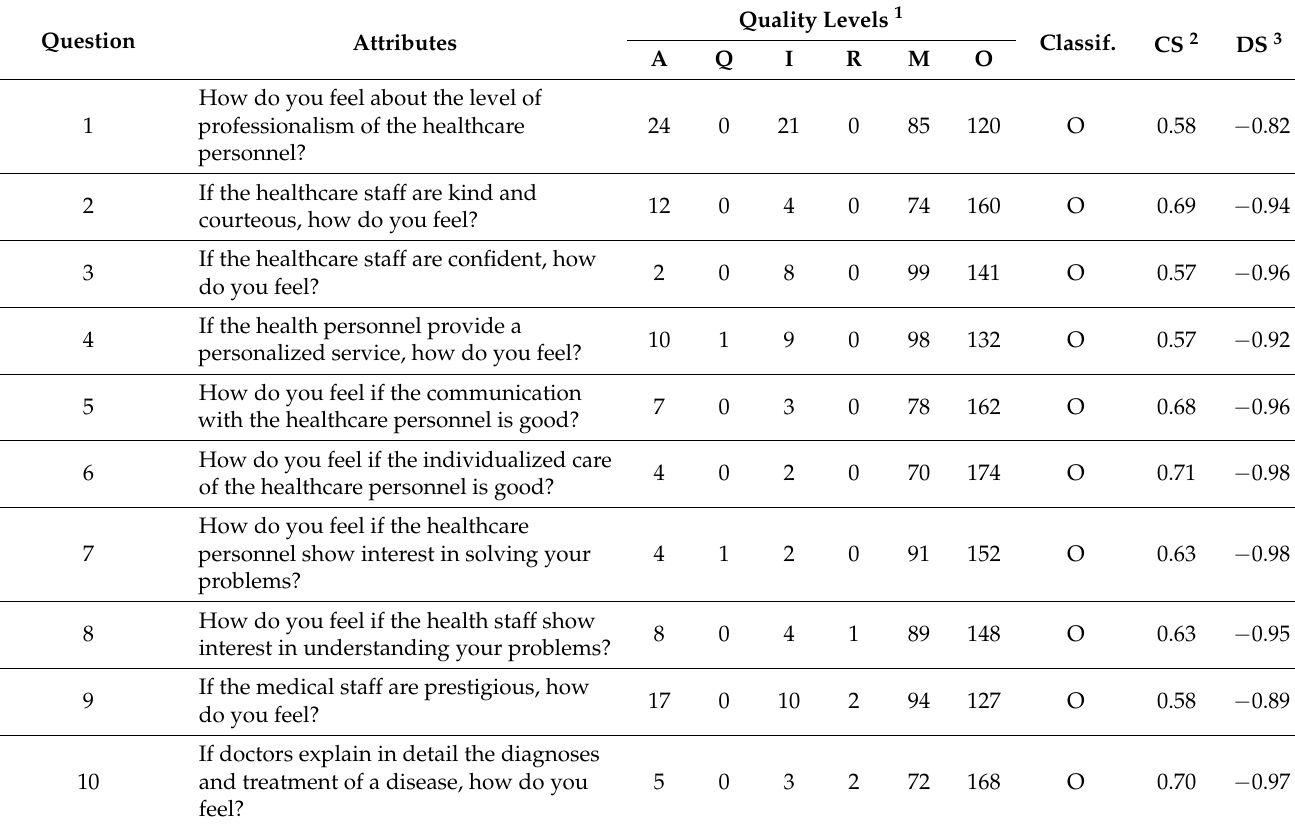
Table 4. Results corresponding to the health personnel